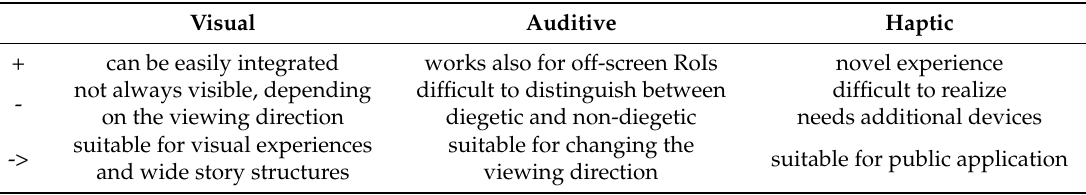
Table 5. Advantages and disadvantages of visual, auditive and haptic methods. The third row indicates for which requirements the methods are suitable.